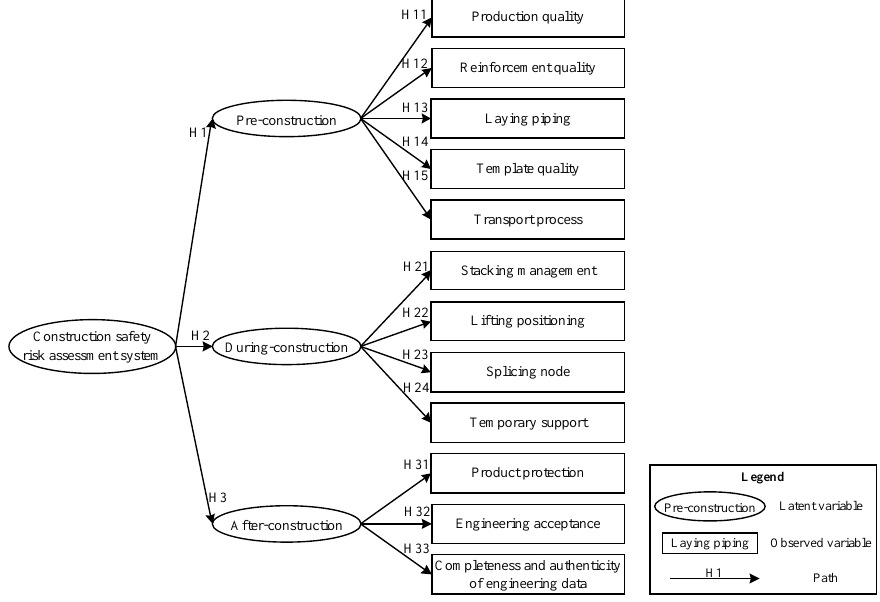
Figure 1. Hypothetical relational